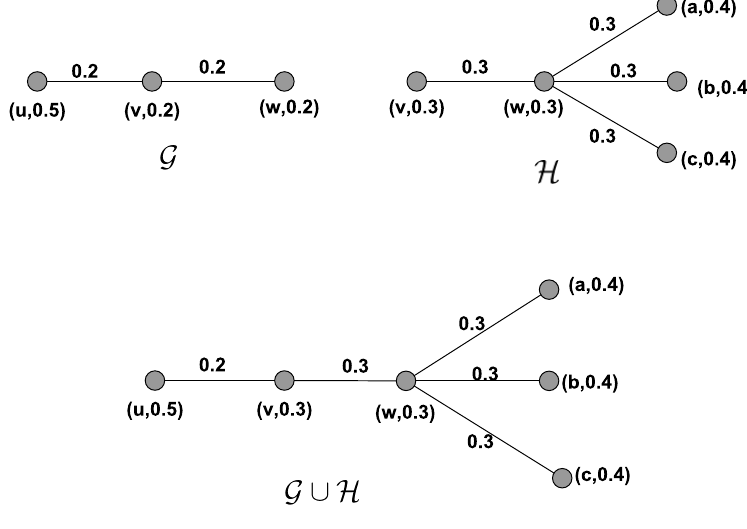
Figure 2: Fuzzy Graphs G , H and G ∪